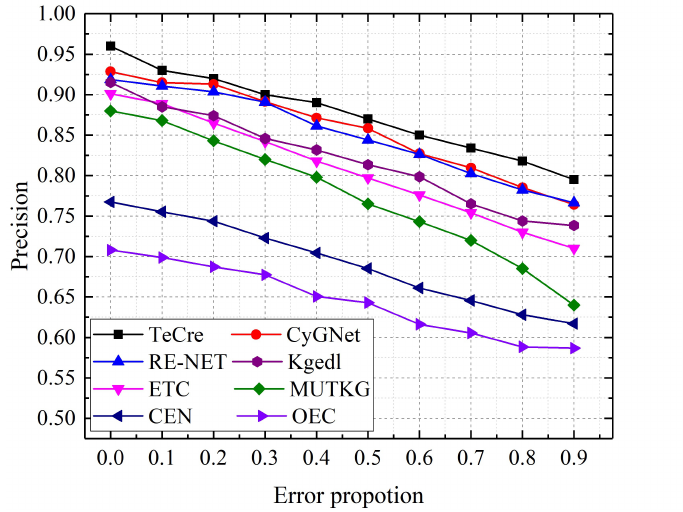
Figure 7. Precision on YAGO15K with different error